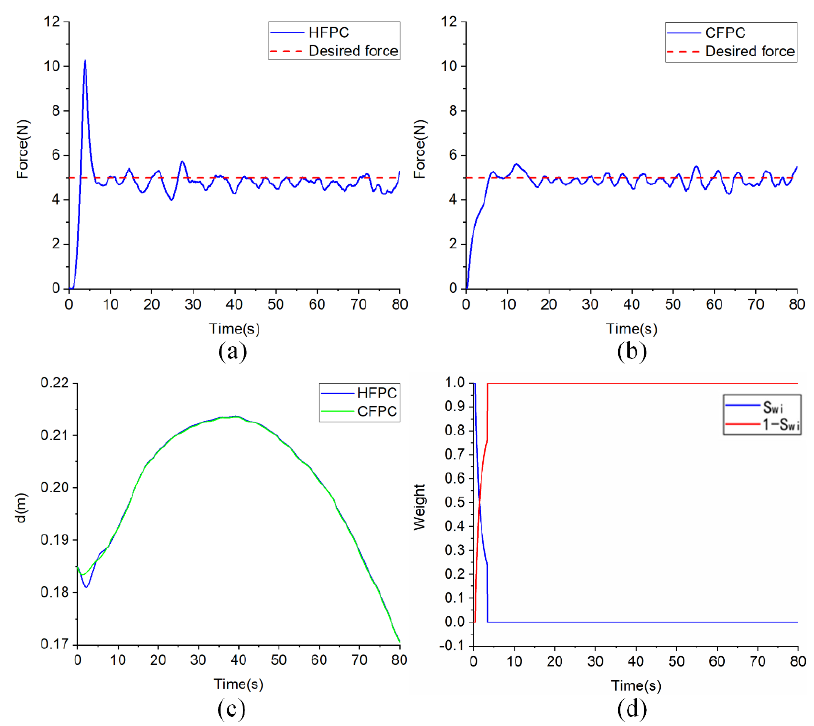
Figure 12. Constant force-tracking experiment on curved surface. Force tracking using ( a ) the HFPC